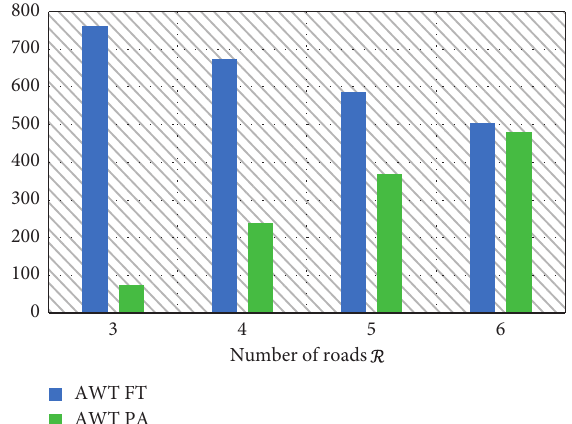
Figure 24: Effect of changing the number of roads at the inter- section (one road has a high rate and the others have a low rate) on the average waiting time.